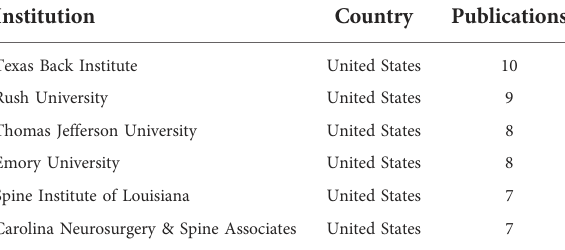
TABLE 2 Institutions with multiple publications of the 100 top-cited articles on